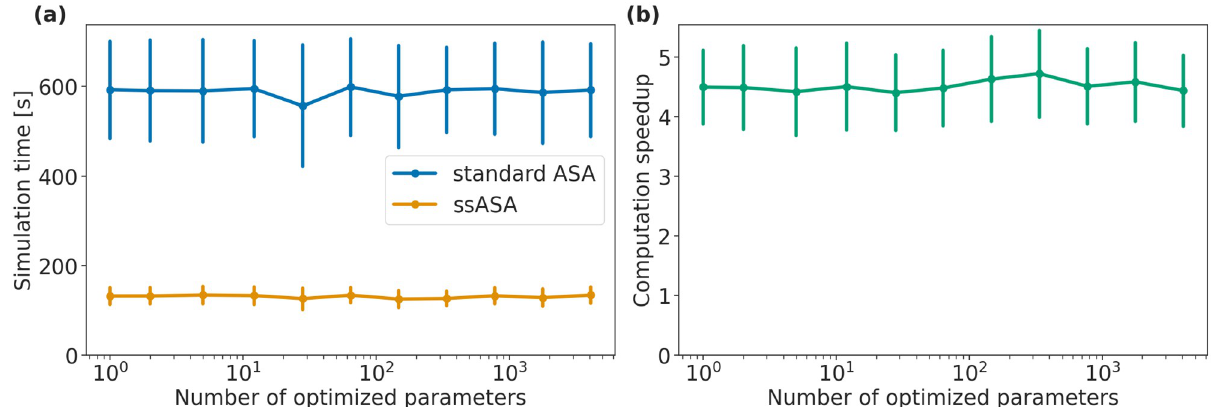
Fig 5. Scaling of simulation time and computation speedup of simulations with respect to the number of optimized parameters. Fro¨hlich et al ., 2018 model, 200 simulations with 1, 2, 5, 12, 28, 64, 147, 337, 775, 1780, 4088 optimized parameters. (a) Each point is the mean simulation time for corresponding number of free parameters, and the error bars are the standard deviations. (b) Each point represents computation speedup of simulations performed with ssASA for sensitivities compared to using standard ASA for sensitivities, the error bars show the standard deviation.